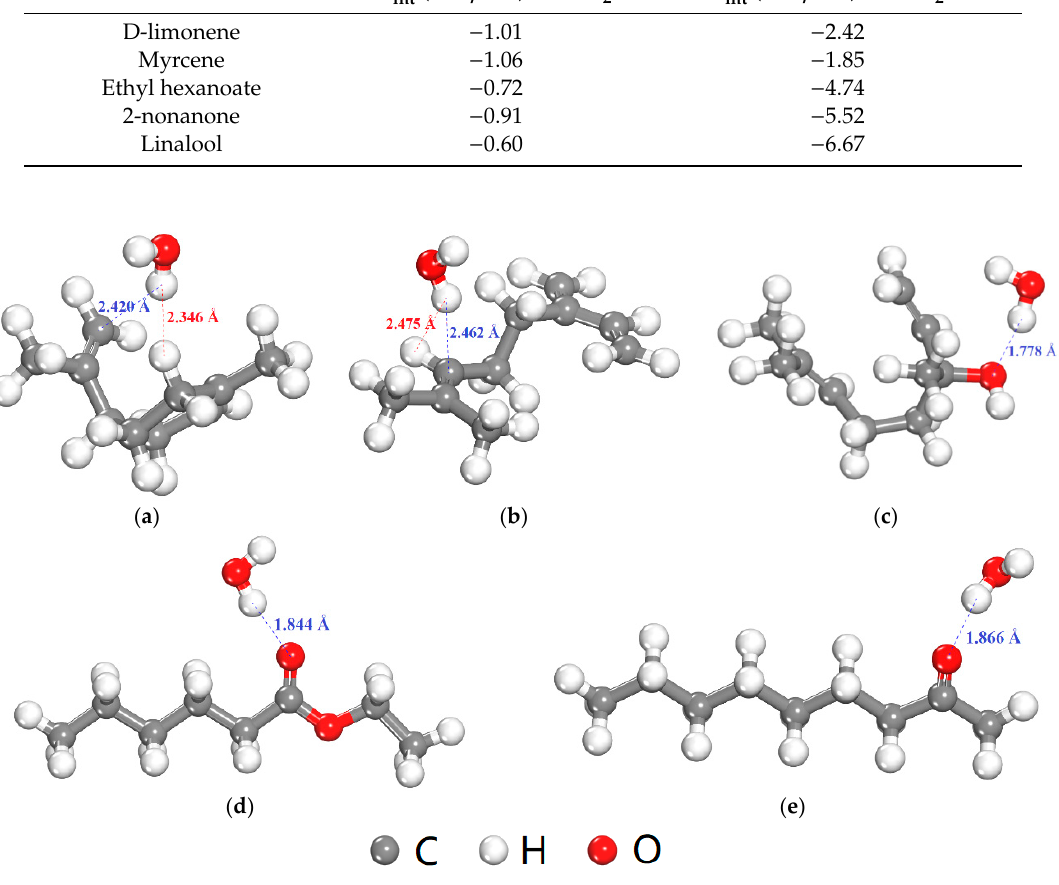
Figure 9. Equilibrium adsorption configurations of H 2 O molecule with five flavor organic molecules (the blue and red dash lines show attraction and repulsion interaction, respectively, determined by a distance criterion of 2.5 Å). ( a ) D-limonene; ( b ) Myrcene; ( c ) Linalool; ( d ) Ethyl hexanoate; ( e ) 2-nonanone.